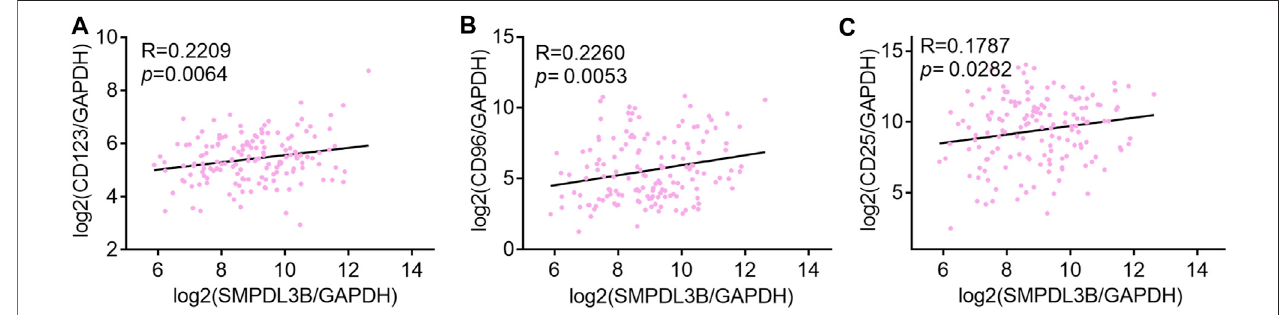
FIGURE 7 | SMPDL3B expression positively correlates with CD123, CD96, and CD25 AML patients. (A – C) The log2 transcription level of SMPDL3B, CD123 (A) , CD96 (B) , and CD25 (C) in AML patients was shown after normalized to GAPDH. n (cid:1) 151, Spearman analysis p <